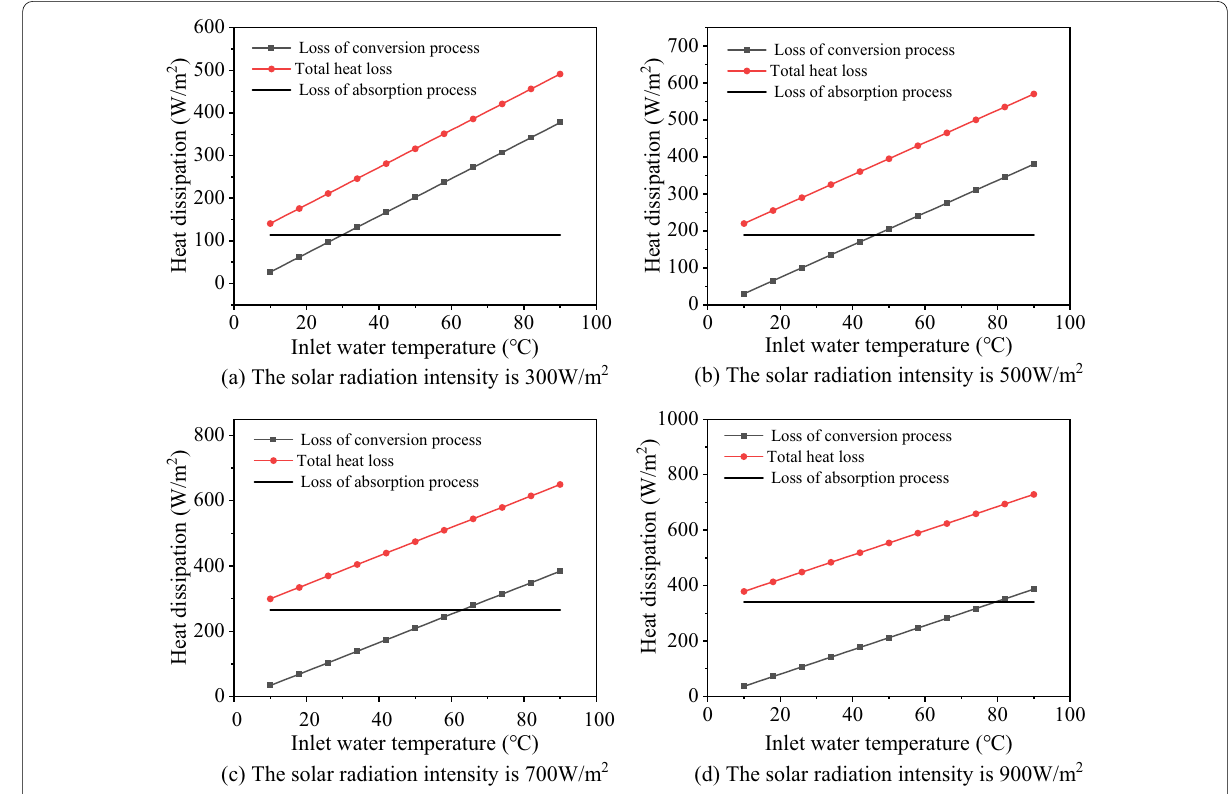
Fig. 8 Relationship between inlet water temperature and heat loss of